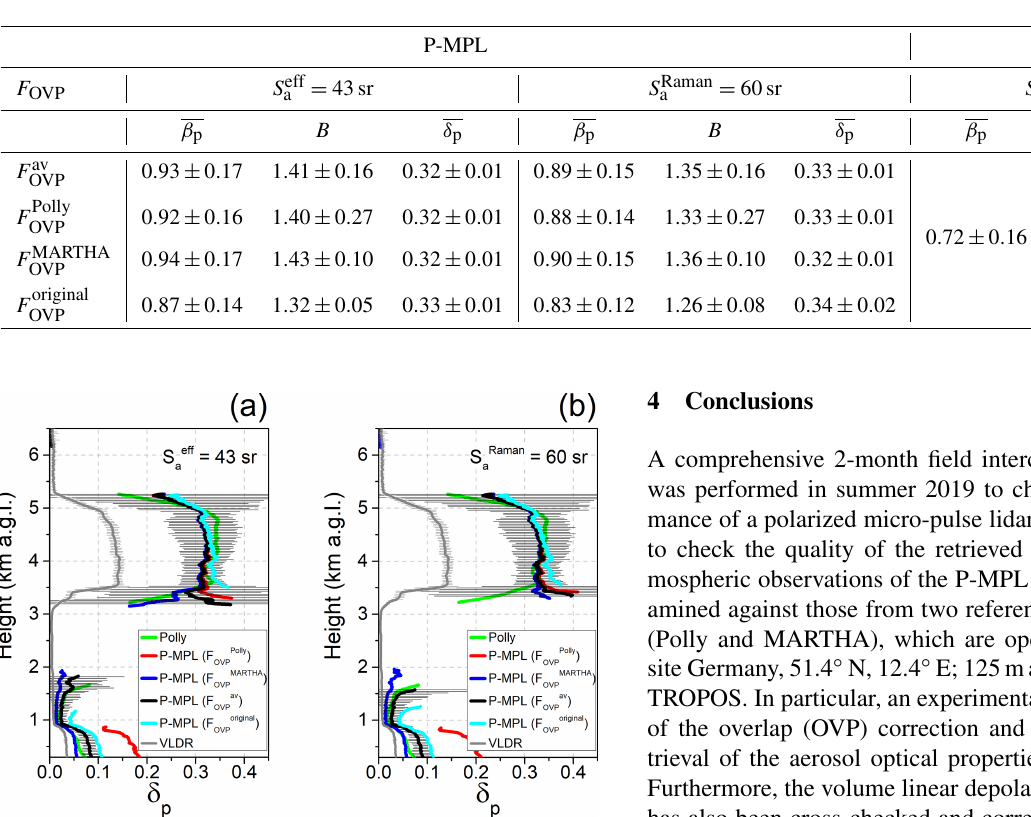
Table 3. Dust layer-averaged PBC, β p (Mm − 1 sr − 1 ), and PLDR, δ p , and the integrated backscatter, B (10 − 3 sr − 1 ), values, as obtained from P-MPL β p and δ p profiles on 29 June 2019 at 20:00–21:00UT depending on the F OVP applied for both KF solutions (using S eff a and S Raman a ). Corresponding Polly values are also included.